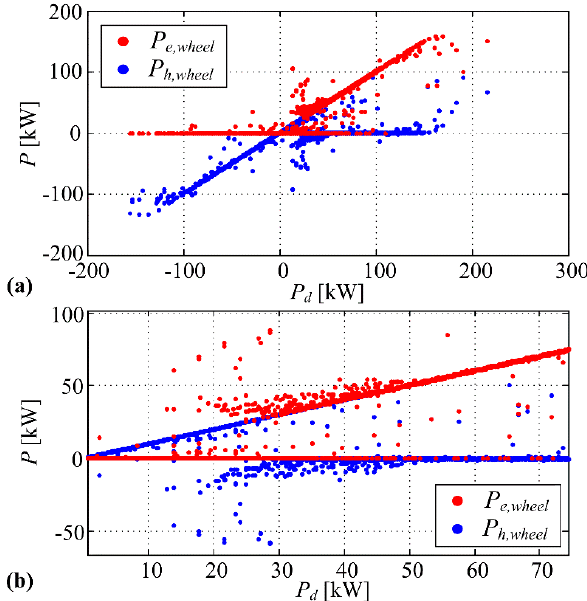
Figure 10. Optimum power for all cycles: ( a ) optimum ICE P e,wheel and hydraulic motor power P h,wheel ; ( b ) detail from ( a ).